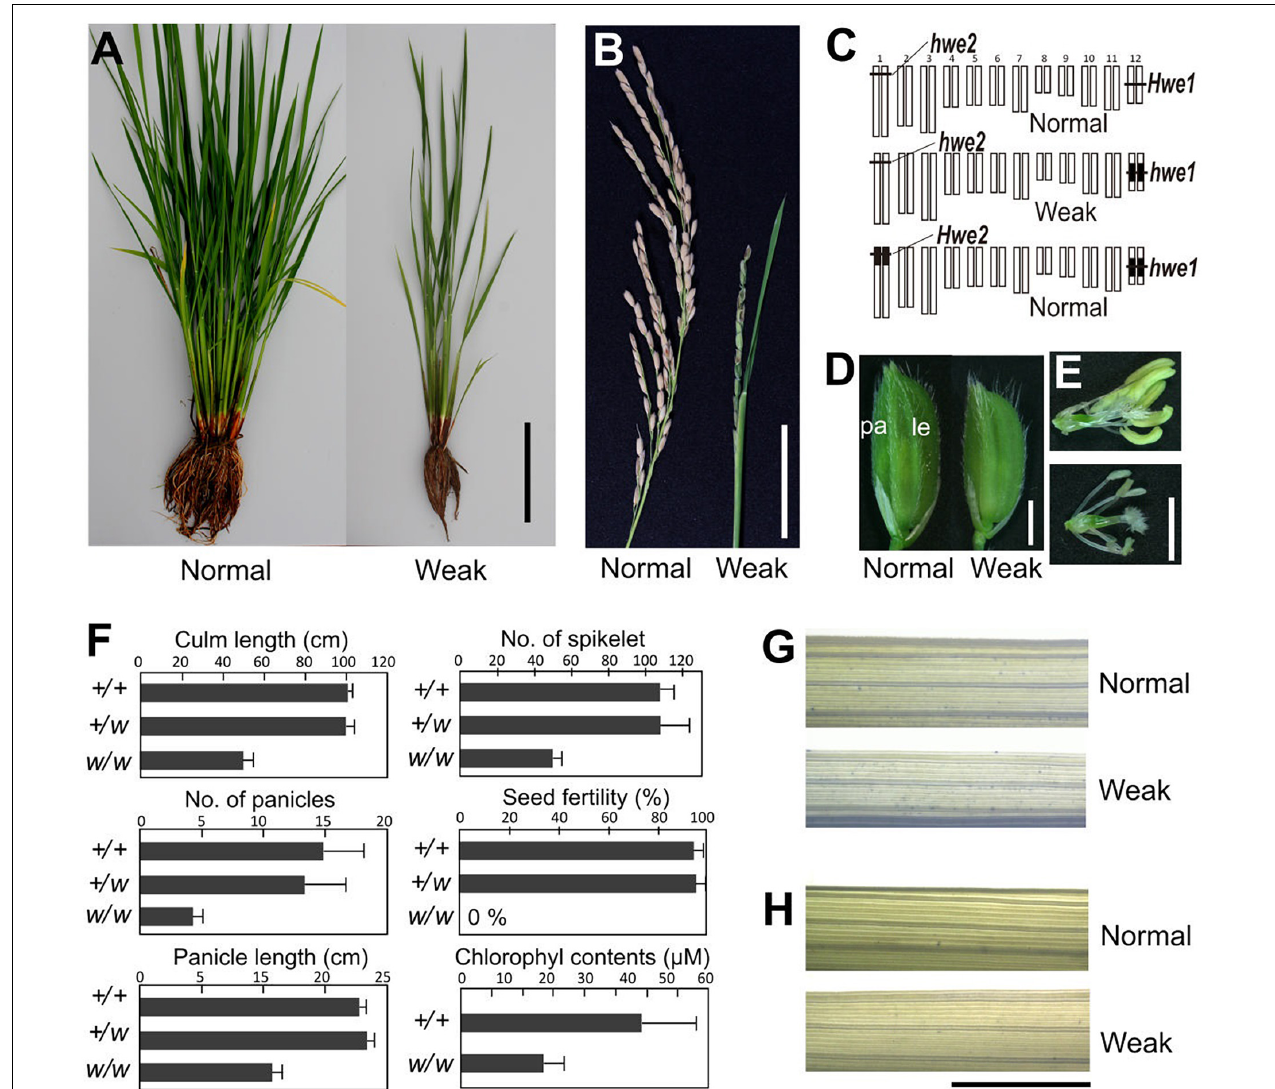
FIGURE 1 | Morphology of weak plants. (A) Plant morphology at vegetative stage 3 weeks before heading. (B) Morphology of panicle at the mature seed stage. Weak plants exhibited a partially sheathed panicle. (C) Graphical genotype of weak plants. White and black bars represent Asominori and IR24 chromosomes, respectively. Only the double recessive homozygote showed the weakness phenotype. (D) Spikelets of normal ( left ) and weak plants ( right ). Le, lemma; pa, palea. (E) Flower organs of normal ( upper ) and weak plants ( lower ). (F) Characterization of weak plants. Column length, number of panicles, number of spikelets per panicle, seed fertility, and leaf chlorophyll contents at 3 weeks before flowering. +/+: Hwe1/Hwe1 hwe2/hwe2 , +/w: Hwe1/hwe1, hwe2/hwe2 , and w/w: hwe1/hwe1 hwe2/hwe2 . N = 10 for each genotype excluding the chlorophyll contents ( N = 5). (G,H) Trypan blue staining to assess viability leaf blade cell. Third youngest leaf blades from normal and weak plants at the developmental stage before heading [ (G) , 90 days after sowing] and after heading [ (H) , 120 days after sowing) were stained by trypan blue. Neither showed remarkable cell lethality. Scale bar = 10.0 cm in (A) , 5.0 cm in (B) , 2.0 mm in (D,E) , and 5.0 mm in (G,H)